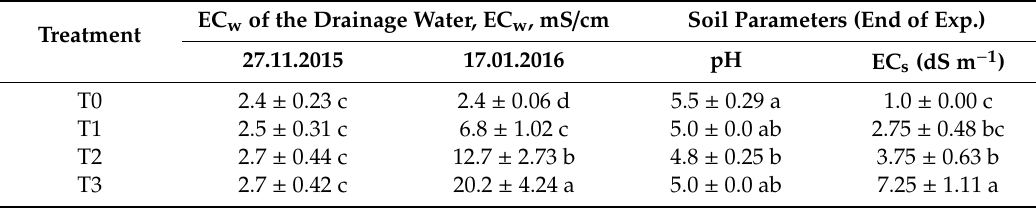
Table 2. Electrical conductivity (EC w ) of the drainage water, pH and EC s of the soil at the end of the experiment. Di ff erent letters within a column represent significant di ff erences ( p ≤ 0.05). EC w of the Drainage Water, EC w , mS / cm Soil Parameters (End of Exp.) Treatment